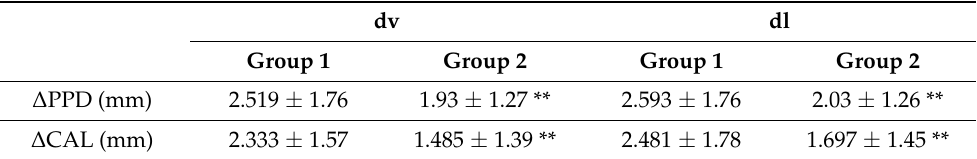
Table 4. Comparison of ∆ values (mean + standard deviation) between young (Group 1) and old patients (Group 2). dv dl Group 1 Group 2 Group 1 Group 2 ∆ PPD (mm)